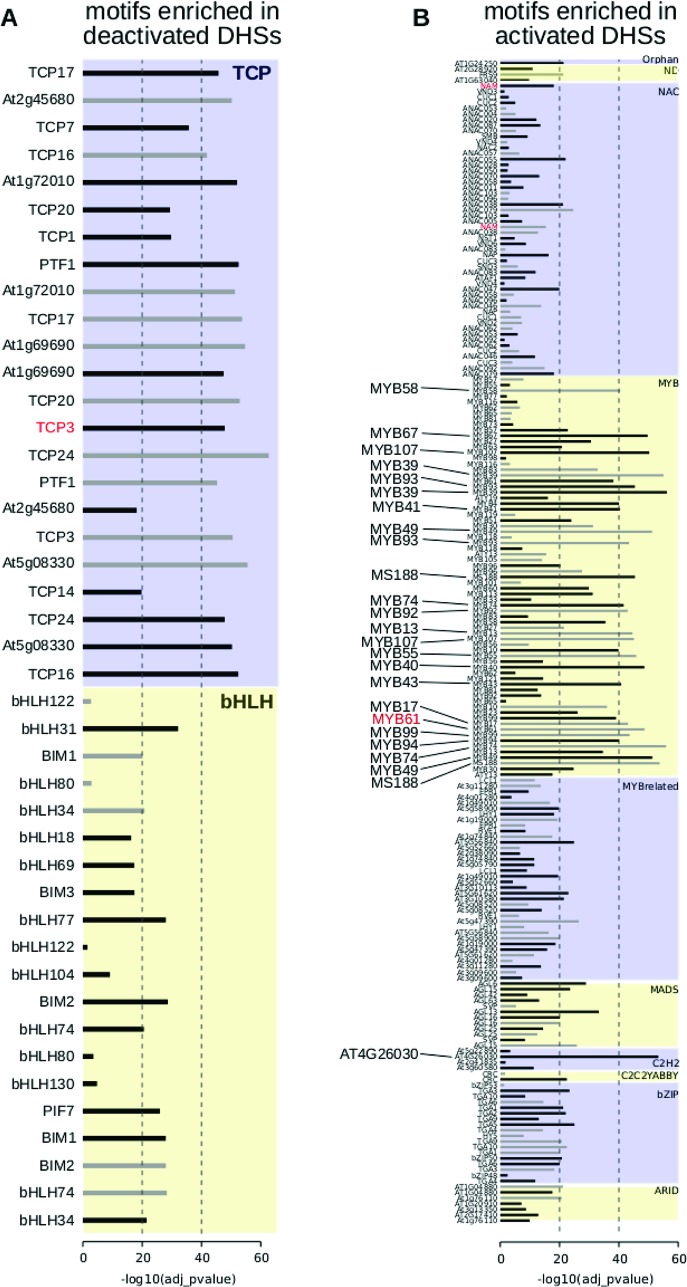
Motif enrichments within dynamic DNase I-hypersensitive sites (DHSs). (A) Transcription factor motifs enriched in DHSs that are deactivated at the 7 DPA time point. (B) Transcription factor motifs enriched in DHSs that are activated at the 7 DPA time point. Dotted vertical line indicates adjusted p-values of 10-20 of 10-40, respectively. All transcription factor family members are displayed if at least one member is enriched with adjusted p-value of 10-20 or less [greater than -log10(10-20) or 20]. Transcription factor motifs derived using amplified (i.e., non-methylated) DNA have gray bars indicating enrichment p-value (O’Malley et al., 2016). Motifs derived from genomic (i.e., methylated) DNA have black bars indicating enrichment p-value.